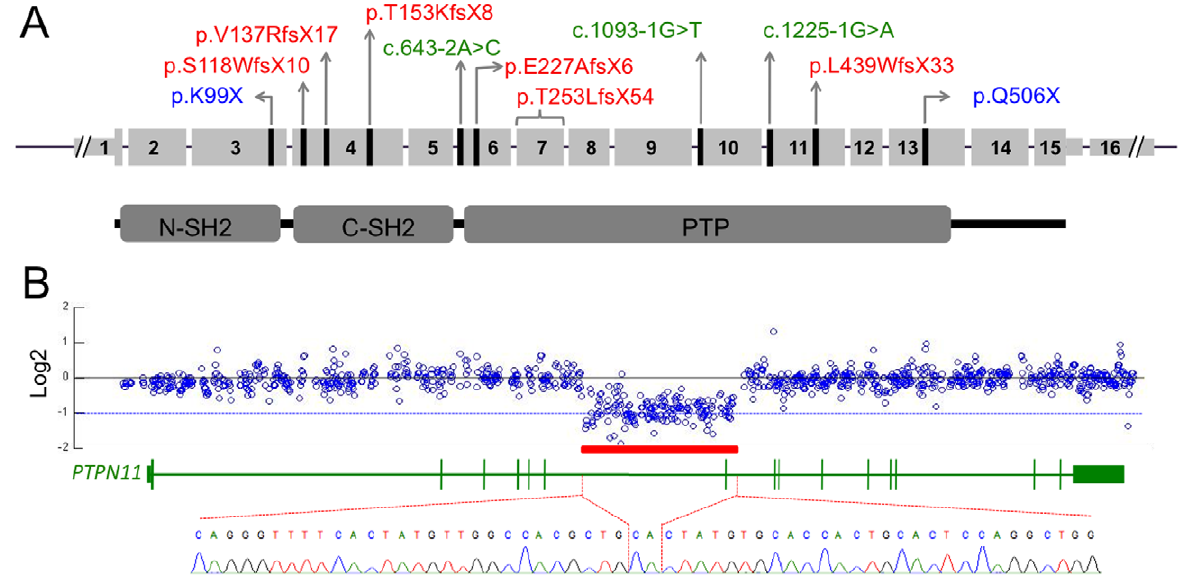
Figure 3. PTPN11 mutations identified in MC participants. (A) Schematic of the exonic structure of PTPN11 (above) and the corresponding protein structure of SHP2 (below). The locations of mutations that were identified in MC are indicated with black lines. Predicted protein changes are indicated for the nonsense (blue) and frameshift (red) mutations, while the cDNA designation is indicated for the splice-site mutations (green). (B) Log2 values of the number of Illumina reads obtained per 50 bp window in participant S, divided by the average number of reads obtained in other participants whose DNA was captured simultaneously using the second capture array. Shown are all 50 bp windows spanning regions of PTPN11 targeted by the array, with the corresponding exonic structure of PTPN11 shown below. The red bar indicates a region spanning exon 7, in which the average log2 value is approximately 2 1, suggesting a heterozygous deletion. PCR amplification and sequencing of the breakpoint, using primers on either end of the deletion, indicate that 14,629 bp of sequence have been deleted and replaced with a single CA